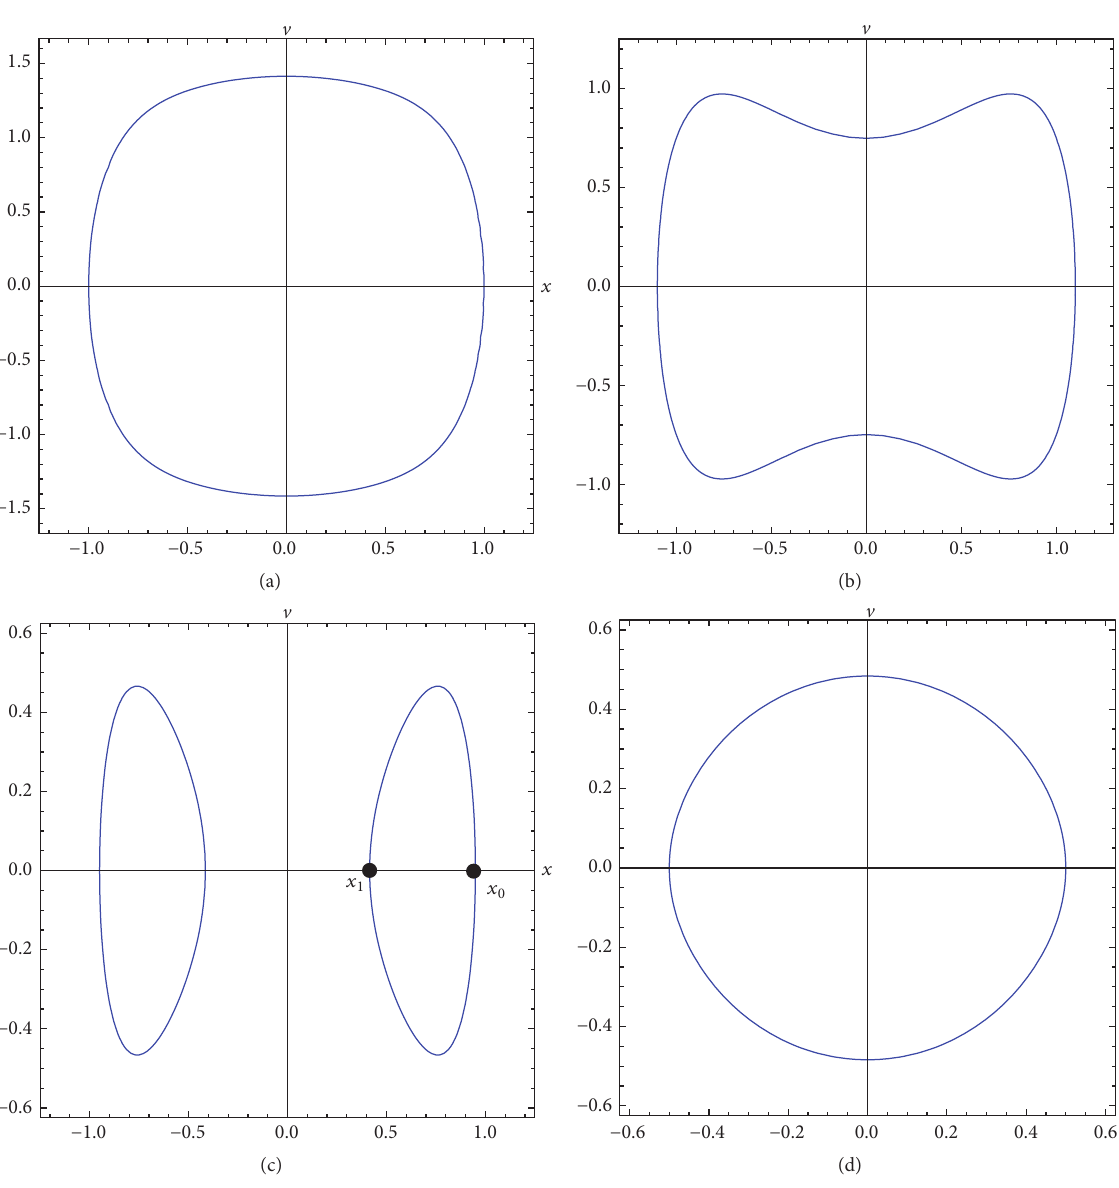
and 𝑥 0 = 0.5 ( 𝑥 0 must be < 3 −1/4 ≈ 0.7598 ). As can